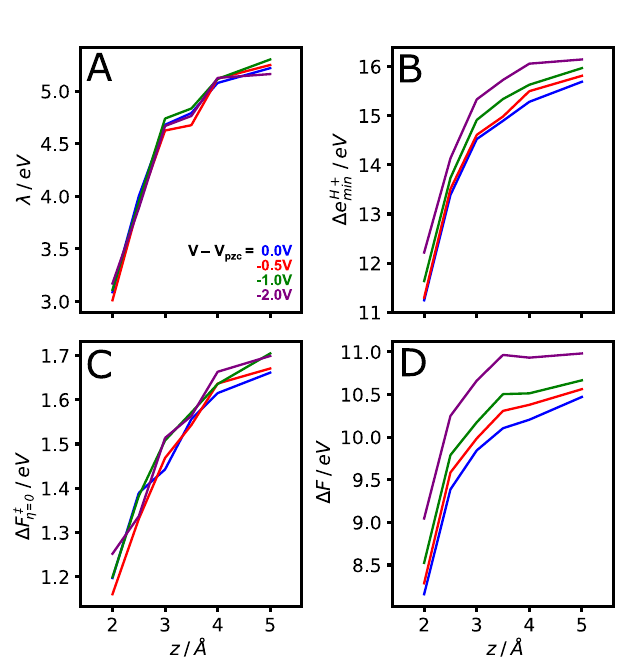
Fig.2|Diabaticfreeenergiesfor H + andreducedHalongthesolventcoordinate at fi xed z. The reduced state free energies are calculated from the oxidized free energies by the relation F H Δ e ð Þ = F H + Δ e ð Þ + Δ e + ϵ a (cid:2) ϵ f and the overpotential is set to η =0 ineachcaseforeaseofcomparison. A z=4.0Å, B z=3.0Å, C z=2.0Å.The